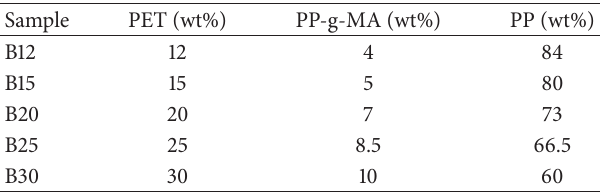
Table 1: Coding and formulations of five blend fibers containing various amounts of